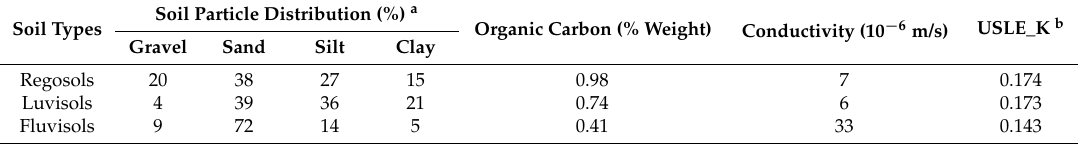
Figure 2. The spatial data in the Baocun watershed for the SWAT-WB-VSA model: ( a ) Topographic index ln(A/tan β ); ( b ) soil type map; and ( c ) average annual land use map. Table 1. The physical characteristics of three major soil types in the Baocun watershed.